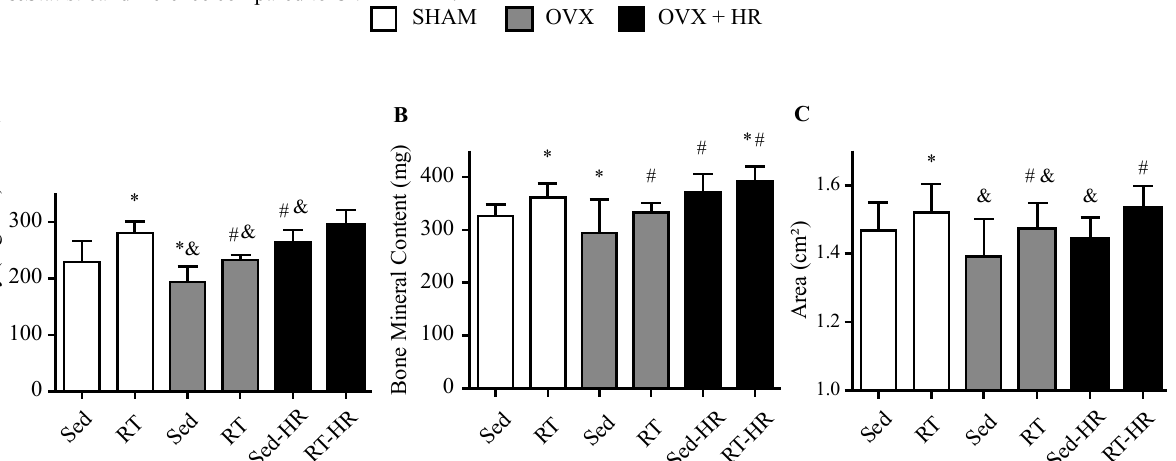
FIGURE 1: Physical analysis of the left tibia: A) bone density (mg/cm3), B) bone mineral content (mg), and C) area (cm2). Values are presented as mean ± standard deviation of mean (SDM), P < 0.05. *Statistical difference compared to SHAM Sed, #Statistical difference compared to OVX Sed, and &Statistical difference compared to OVX RT-HR.